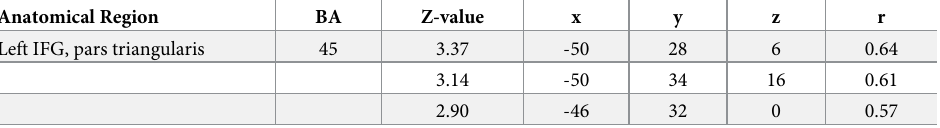
Table 3. Correlations between scores of subjective feeling of being rejected and perfusion changes in contrast exclusion minus inclusion. Anatomical